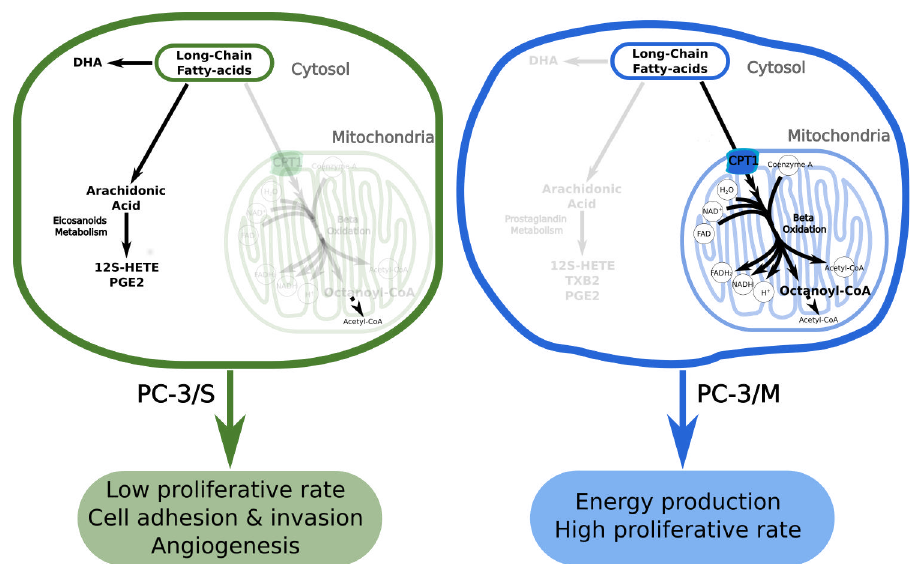
Fig 4. Proposed mechanism of metabolic reprogramming and the resultant phenotypes associated with PC-3/M and PC-3/S cells. A: Metabolicpathways predominantly active in PC-3/S cells (black solid arrows). Inactive/poorly active pathwaysare representedas blurredarrows. B: Metabolicpathways predominantly active in PC-3/M cells (black solid arrows). Inactive/poorly active pathways are representedas